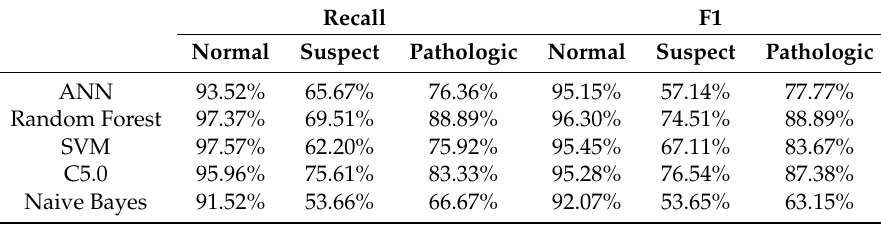
Table 8. Evaluation Criteria for Diabetics patient data after Genetic algorithm.